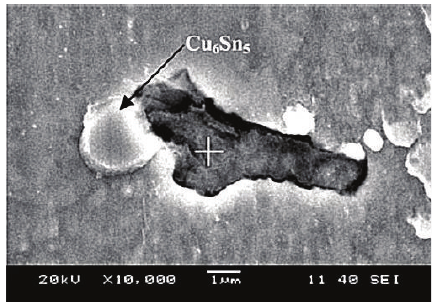
Figure 7: Sn-Nd phase